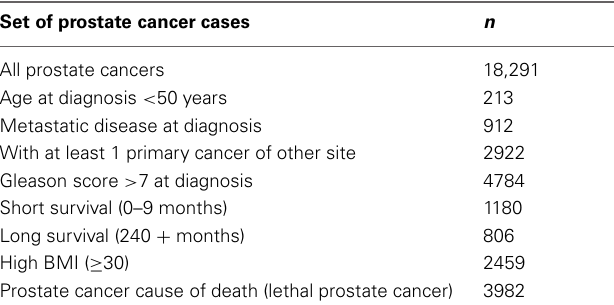
Table 1 | Subsets of prostate cancer and sample